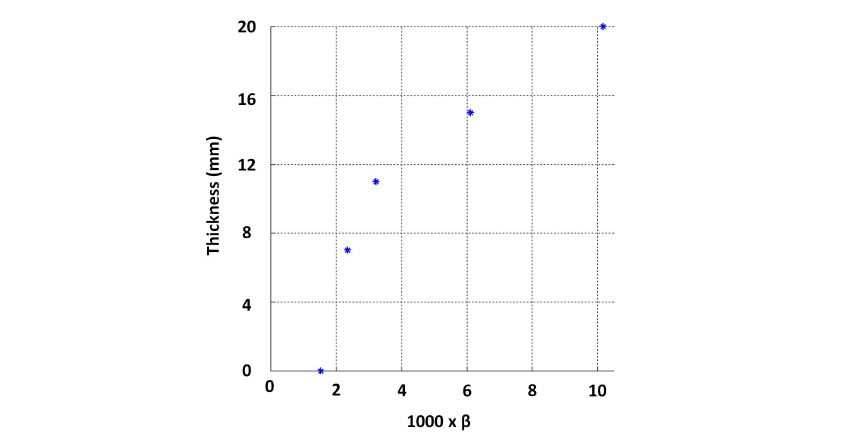
Figure 14. Functional behaviour between thickness and β obtained from calibration blocks.